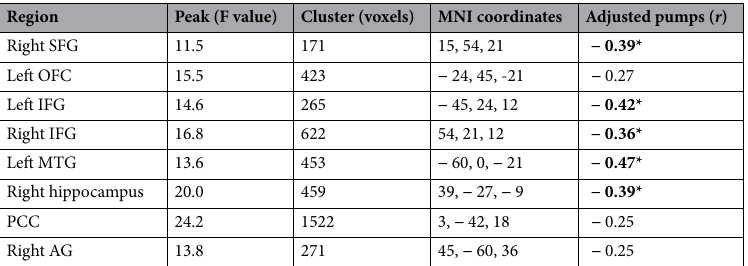
wise, a significant difference was observed in the relationships between the left IFG-putamen connectivity and putamen GM across the three groups (Wald’s χ 2 = 6.4, p = 0.042), showing changed relationship in the OA2 group (Fig. 5C). In addition, non-interested covariates were controlled in the model, including years of educa- tion, brain atrophy, and head motion. There was no significant group effect on the relationships between puta- men GM and other connections.